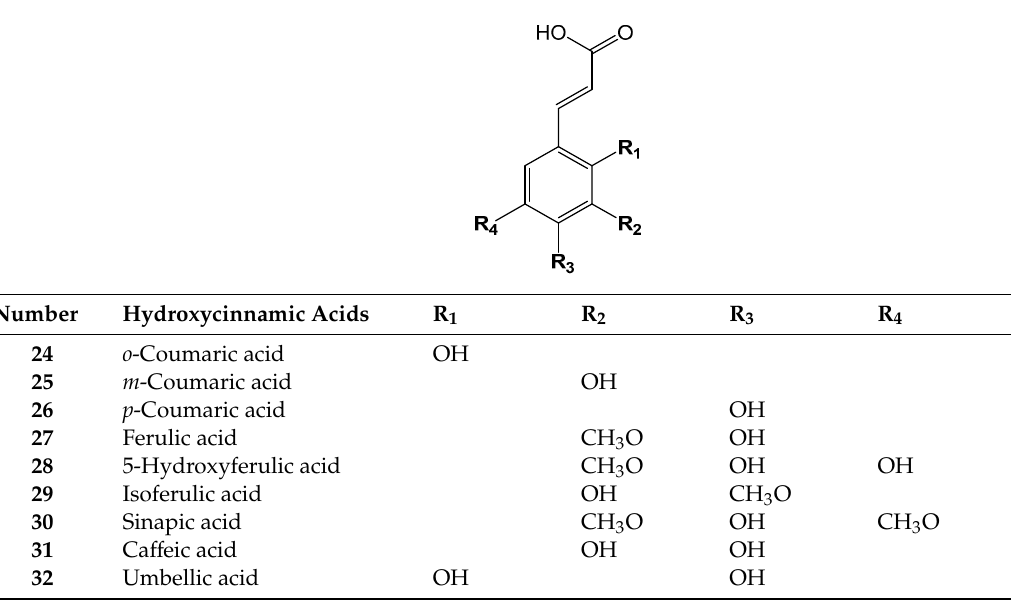
Table 2. The structure of hydroxycinnamic acids. The table represents the functional groups of aromatic ring.